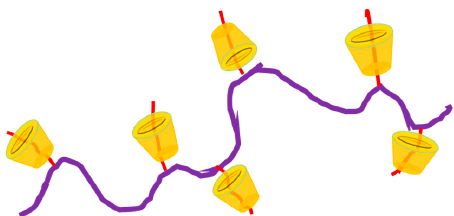
Scheme 3. Hypothetical structure of a polymer network showing a chitosan backbone (purple line) with hydrophilic PEG pendants (red lines) and CD pendants (toroid).